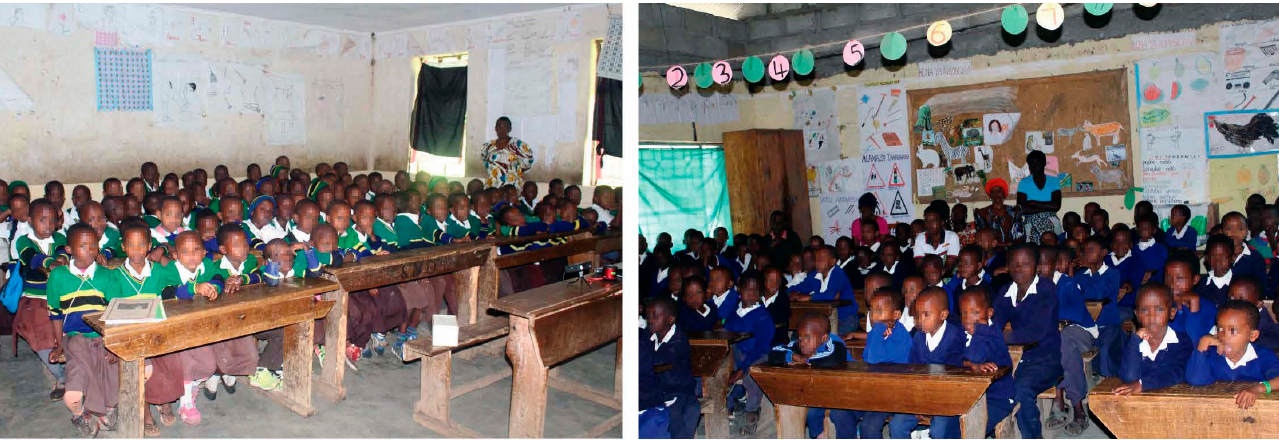
Figure 2. Pre ‐ primary schools in Arusha, Tanzania. Figure 2. Pre-primary schools in Arusha,